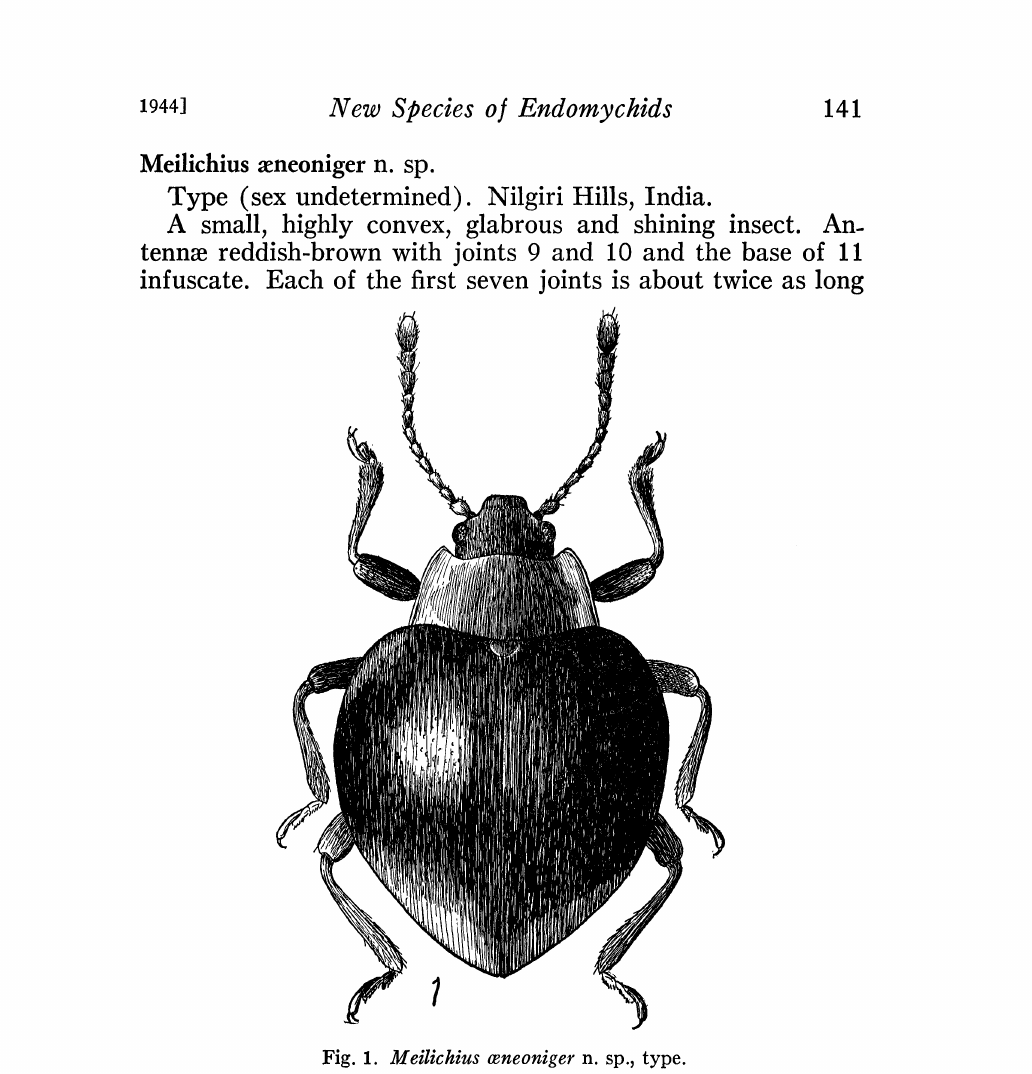
Fig. 1. Meilichius aeneoniger n. sp.,